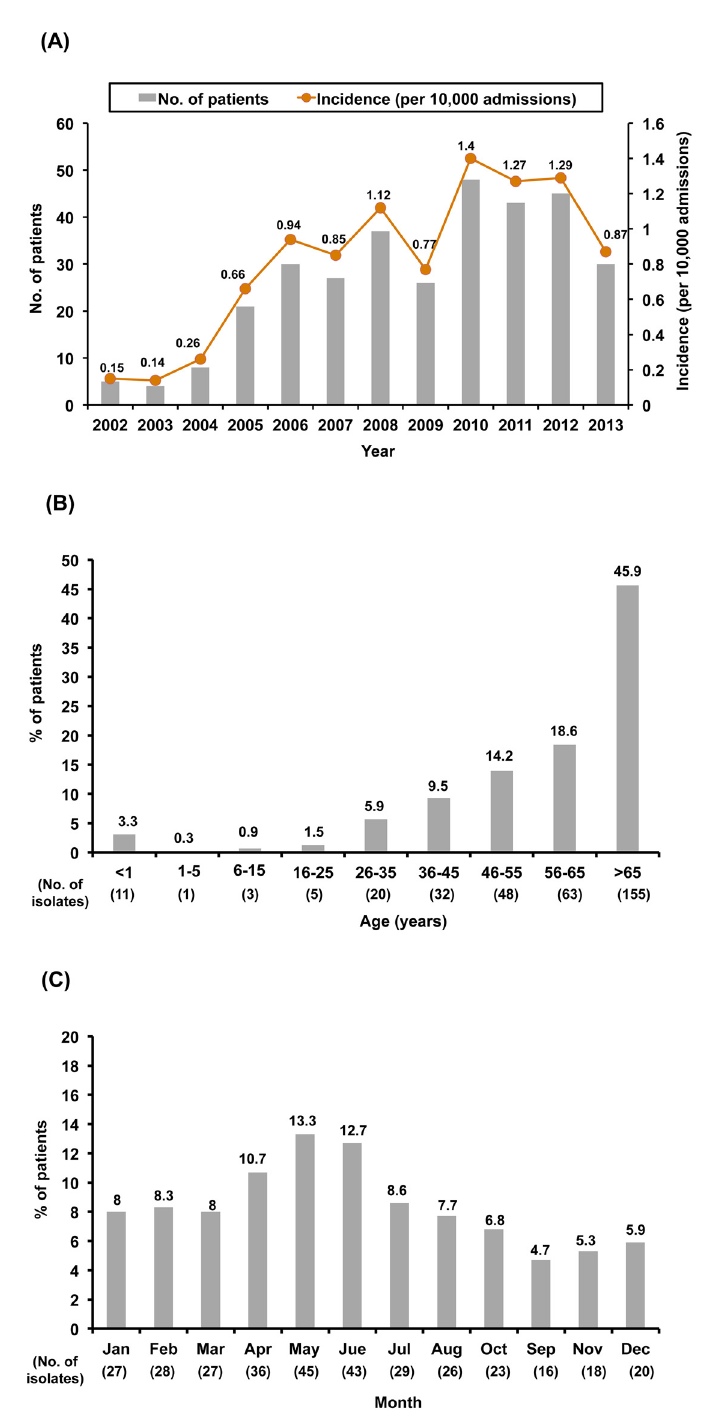
Fig 1. Annual incidence of invasive listeriosis. (A) Annual incidence and number of 338 patients of invasive listeriosis who were treated at four medical centers in Taiwan by year from 2000 to 2013; and (B) distribution of age and (C) months of acquisition of disease among the 338 patients.